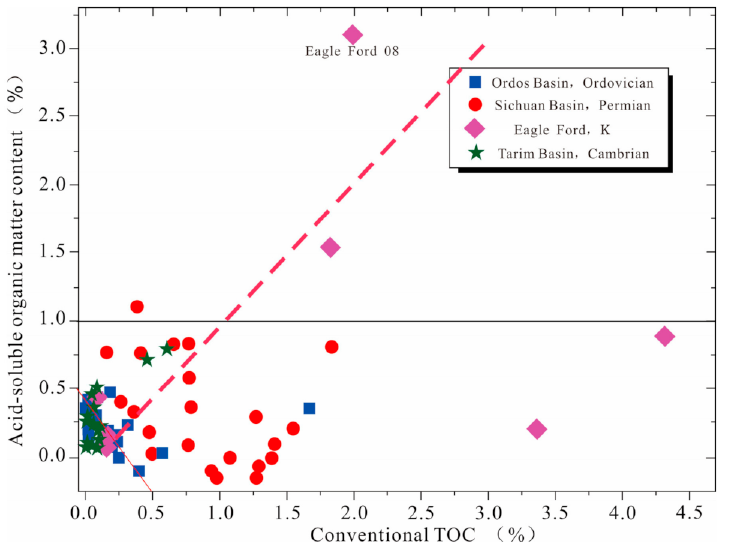
Figure 4. Correlation diagram of acid-soluble organic matter content and TOC of carbonate source rocks in different